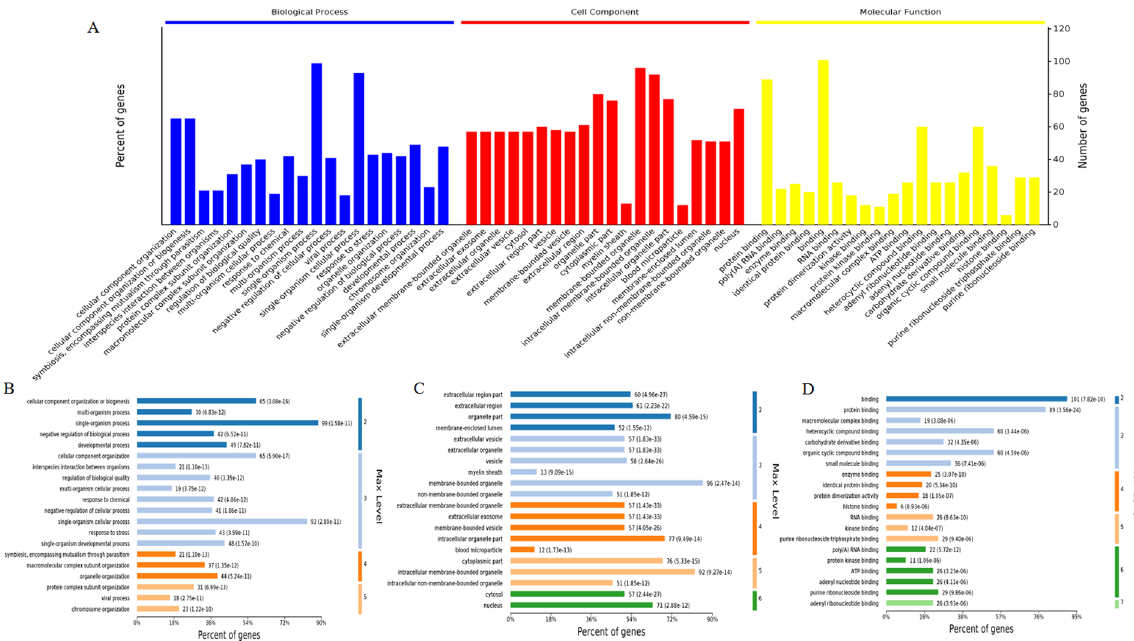
Figure 4. GO annotation of differentially expressed proteins in normal and polysaccharides-treated HepG2 cells. ( A ) The top 20 categories enriched BP, CC and MF. ( B ) The top 20 categories enriched BP terms. ( C ) The top 20 categories enriched CC terms. ( D ) The top 20 categories enriched MF terms.